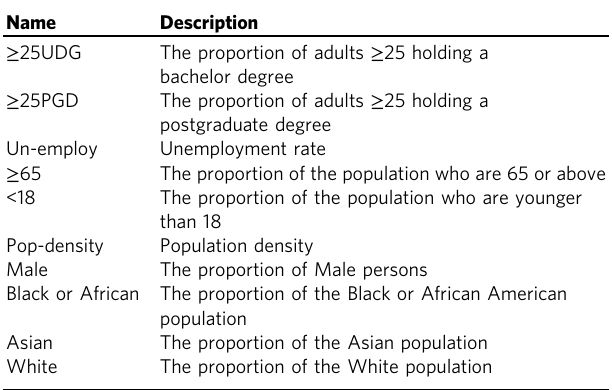
Table 2 Detailed descriptions of the socio-economic features of the SSIG